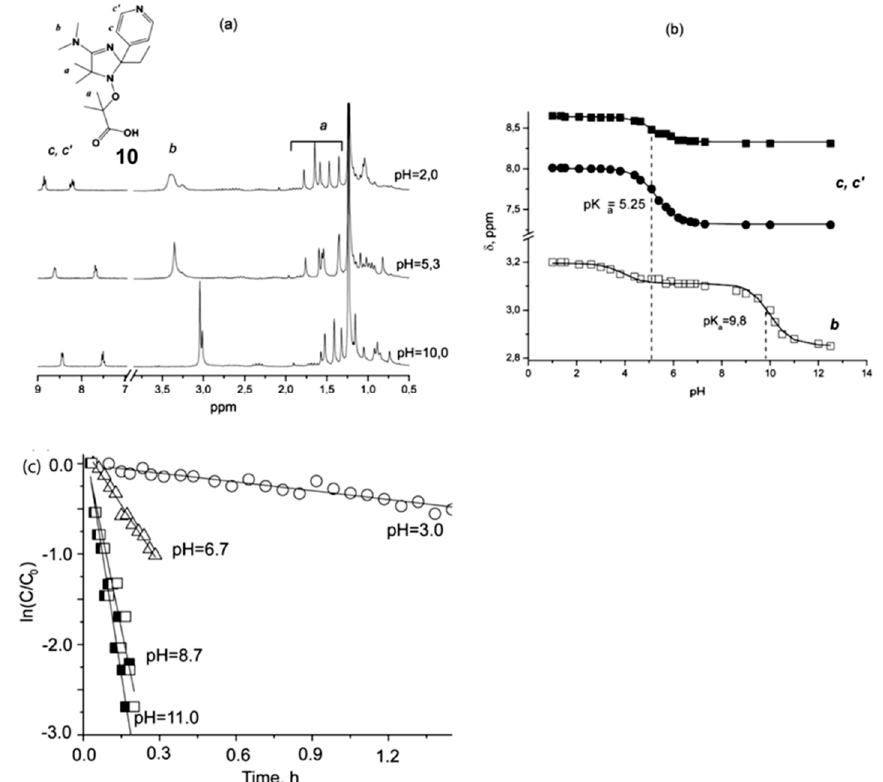
Figure 6. Structures of alkoxyamines 10 – 13